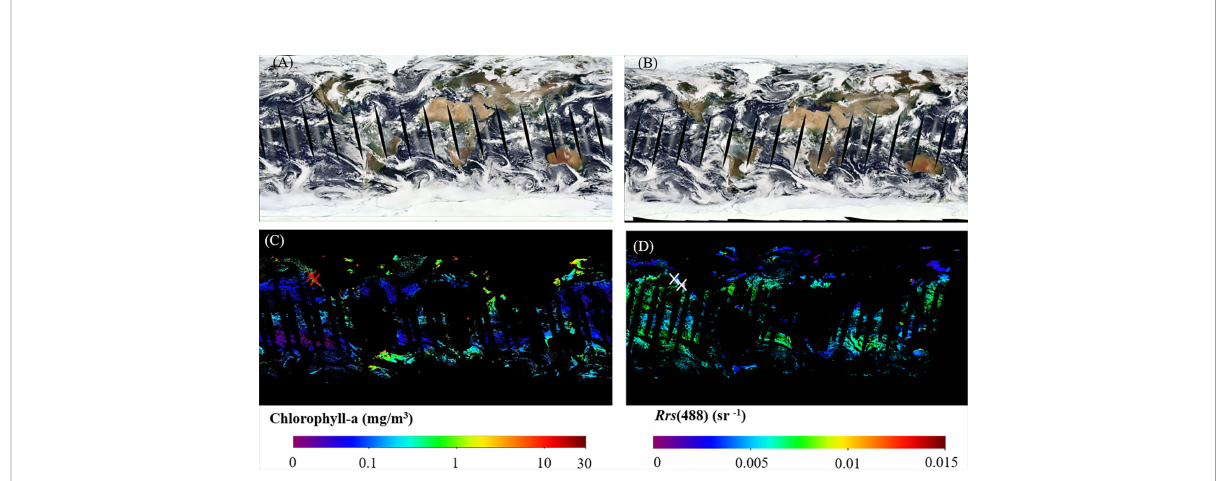
FIGURE 1 The Aqua/MODIS true color composites (A) and Chlorophyll-a product (C) on 10 October 2005. The Terra/MODIS true color re fl ectance (B) and Rrs at the 488-nm product (D) on 13 September 2004. The satellite and in situ matchups are represented by red and white